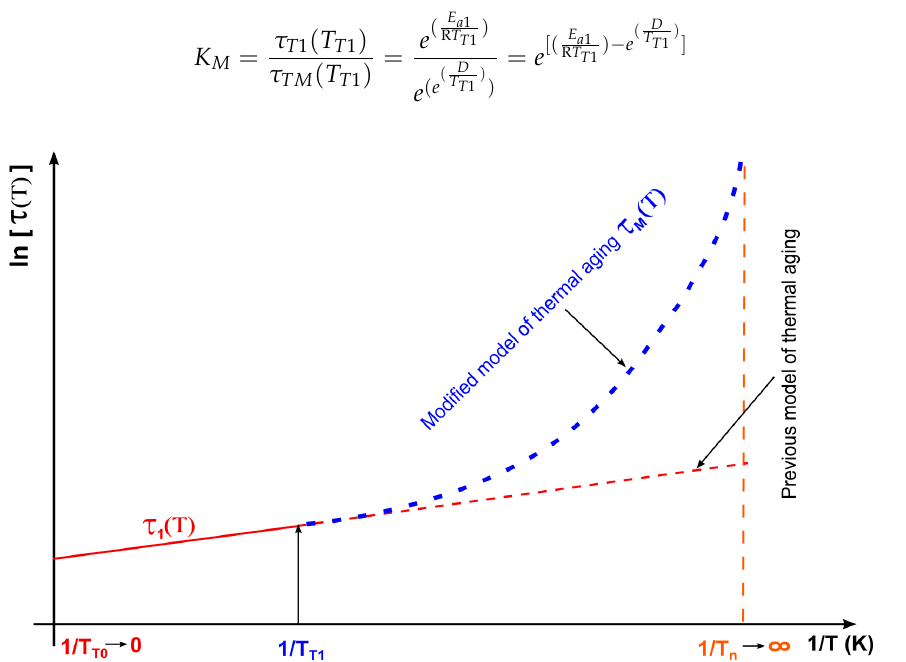
(15) Table 1. Parameter values characterizing the designed thermal aging model for partial degradation mechanisms. i